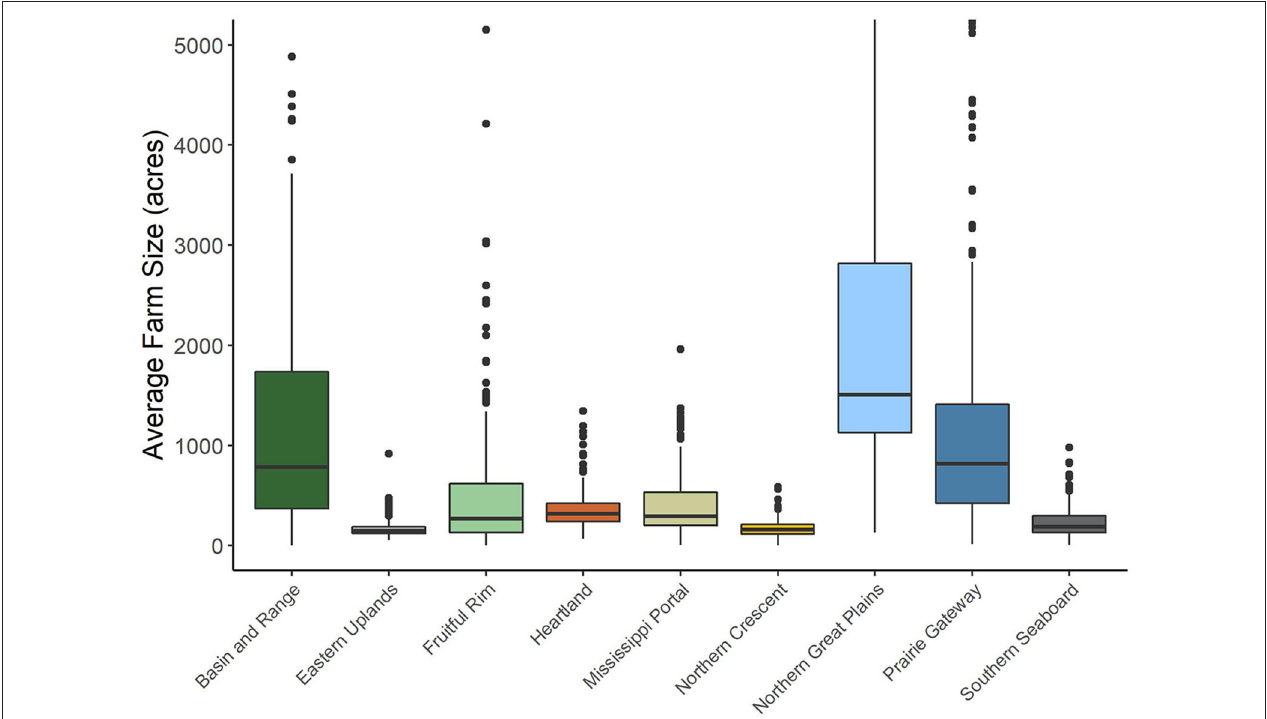
FIGURE 5 | Average farm size (acres per operation) by FRR in 2012. Counties with an average farm size > 5,000 acres [ n = 46, range = 5,119 to 37,952 acres] were removed from visualization for readability. Data: USDA NASS